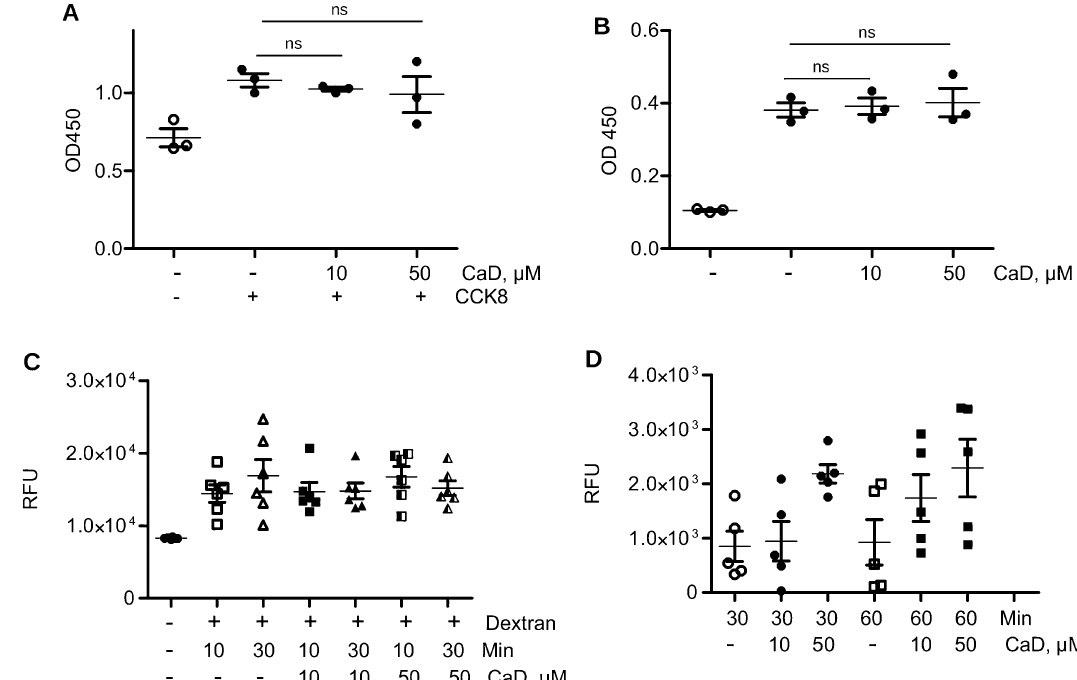
Figure 5. CaD does not cause cell toxicity. ( A ) HMEC-1 were treated with CaD as for cell infection described in Methods. Toxicity was determined by CCK-8 kit 24 h after CaD treatment. Statistical significance was calculated against control without CaD. ( B ) Proliferation of endothelial cells in the presence of indicated concentrations of CaD was assessed using the BrdU incorporation assay (Roche). Statistical significance was calculated against control without CaD. ( C ) Cells were incubated with FITC-Dextran for 10 min and 30 min in the presence of indicated concentrations of CaD, then washed, and fluorescence was measured as described in the methods. Statistical significance was calculated against control without CaD. ( D ) Phagocytosis of FITC- labelled E. coli was assessed in endothelial cells after incubation for 30 and 60 min. CaD was added as